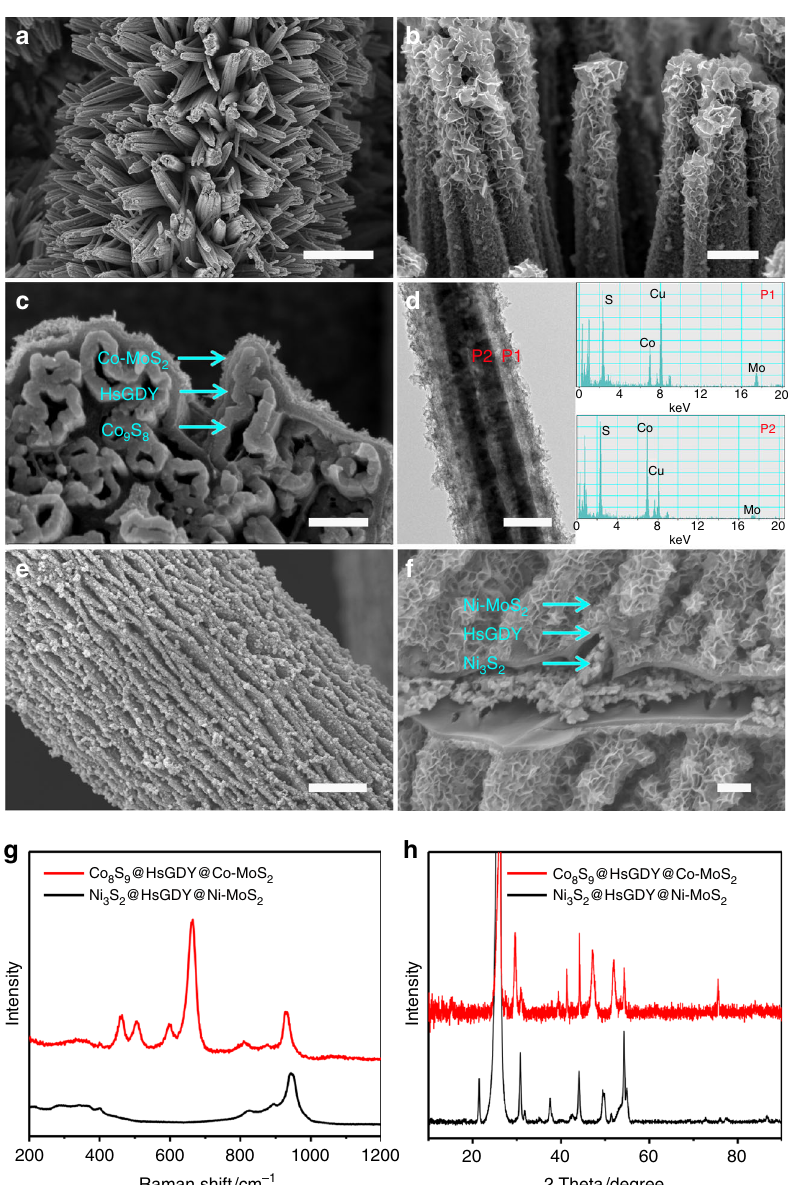
Fig. 6 Structural characterizations of tri-layered nanoarrays. a – c , e , f Scanning electron microscopy (SEM) images, d transmission electron microscopy (TEM) image with corresponding energy dispersive spectroscopy (EDS) spectra, g Raman spectra, and h X-ray diffraction (XRD) patterns of the tri-layered Co 9 S 8 @ hydrogen-substituted graphdiyne (HsGDY)@Co-doped MoS 2 (Co-MoS 2 ) nanotube arrays ( a – d ) and Ni 3 S 2 @HsGDY@ Ni-doped MoS 2 (Ni-MoS 2 ) nanosheet arrays ( e – f ). Scale bars: a 5 μ m, b 500 nm, c , f 200 nm, d 100 nm, e 2 μ